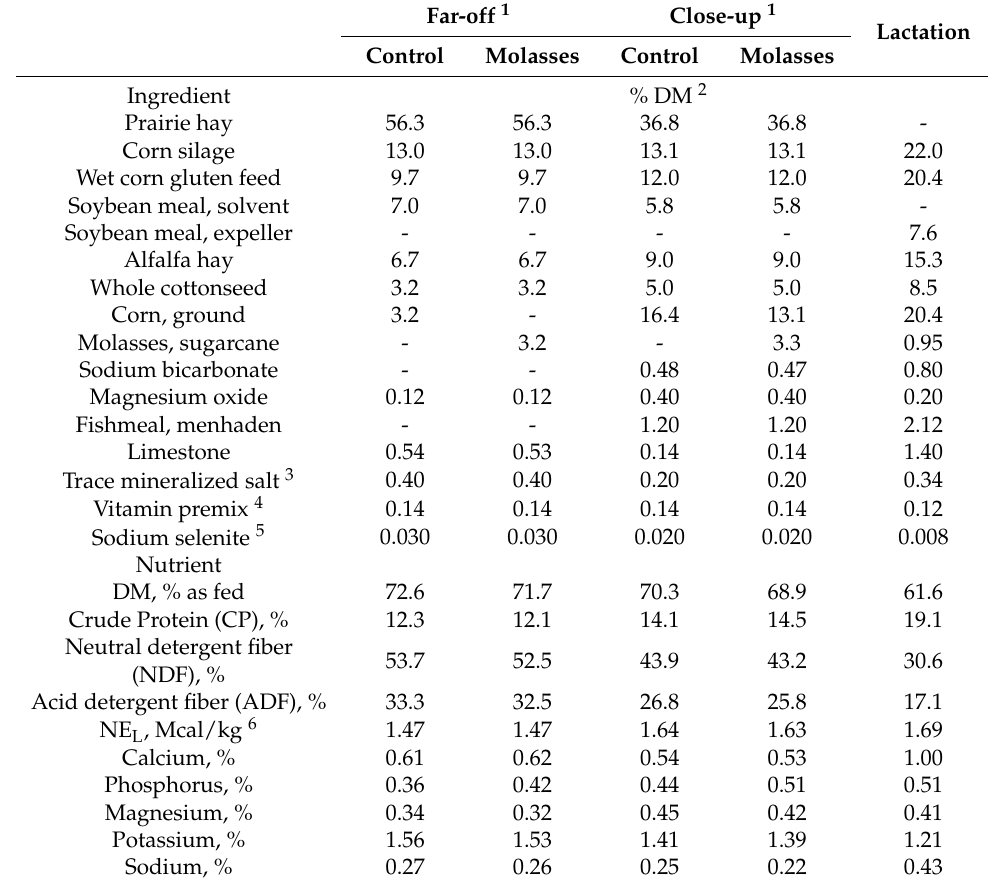
Table 1. Ingredient and nutrient composition of control and cane molasses-containing diets offered during a 60 day dry period for Experiment